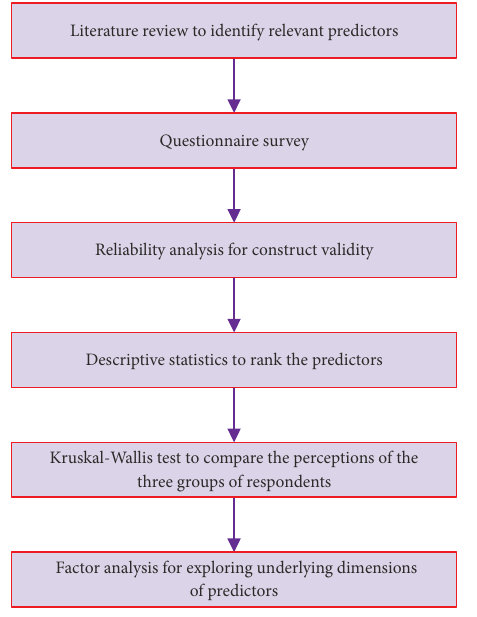
Figure 1. Methodological flowchart for the